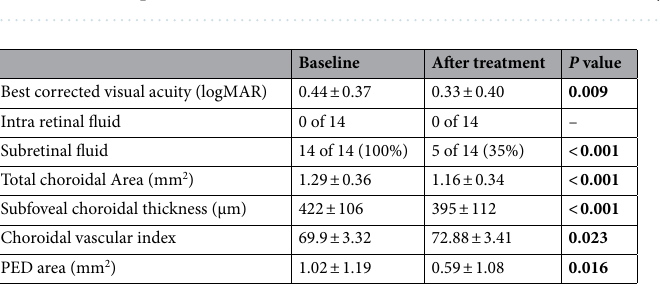
Table 2. Alteration of vision, macular fluid status, choroidal parameters and PED area after half dose photodynamic therapy in patients with avascular FIPED.